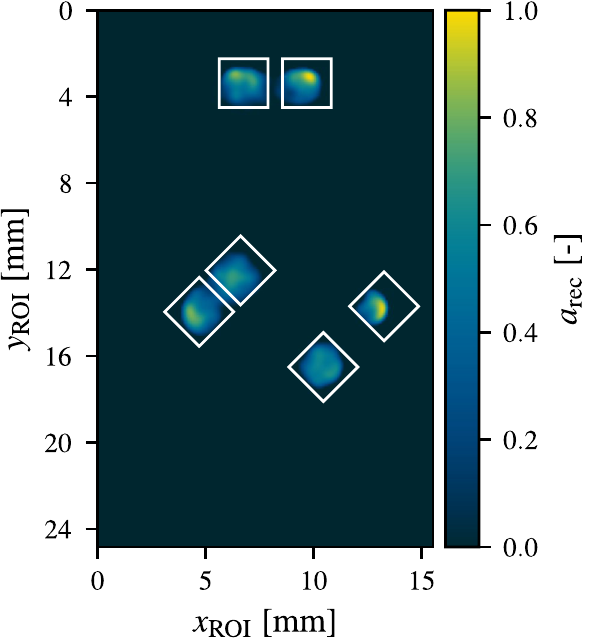
Figure 7. Reconstruction result a rec ( x , y ) obtained for � best = ( 490, 34.4 ) with ρ ADMM = 9900 for an illumination with n m = 20 patterns with d spix = 0.4 mm and β = 0.5 after n iter = 100 iterations. The true defect postions are indicated by white boxes. All defects have been detected with a reasonable reconstruction of the defect